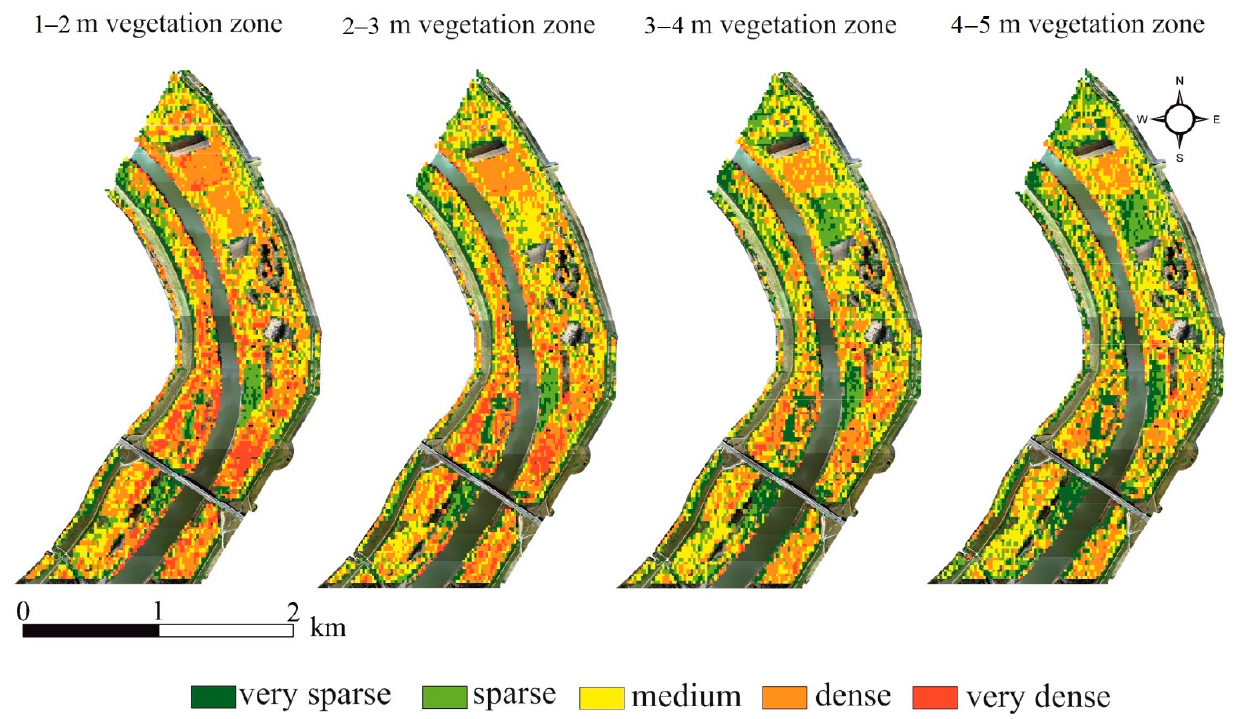
Figure 12. Spatial distribution of various density classes at the four vegetation zones.